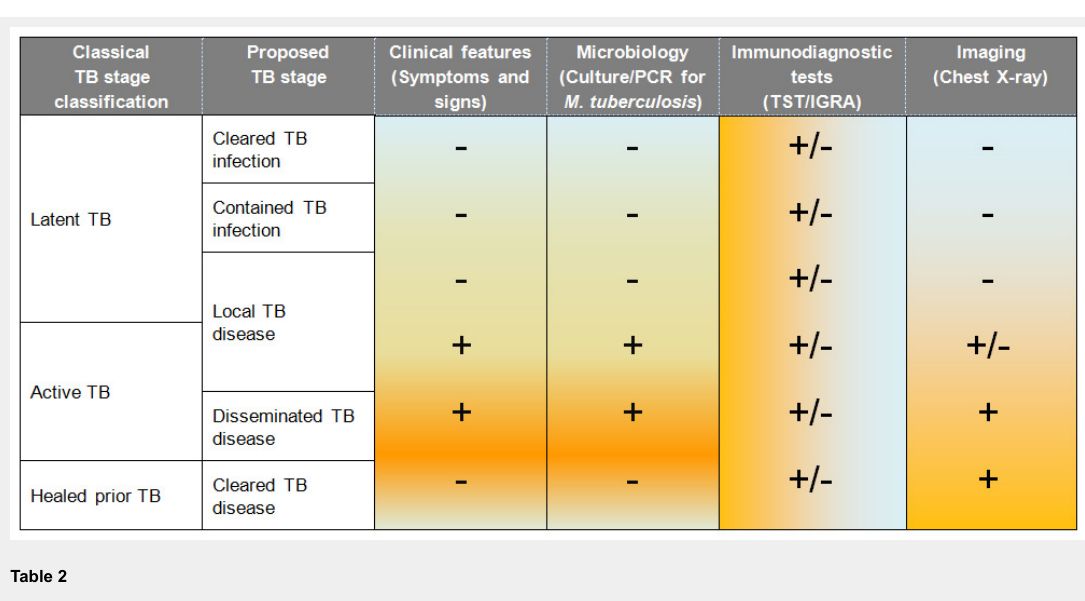
Proposed continuum of stages between infection and disease in childhood tuberculosis (adapted from